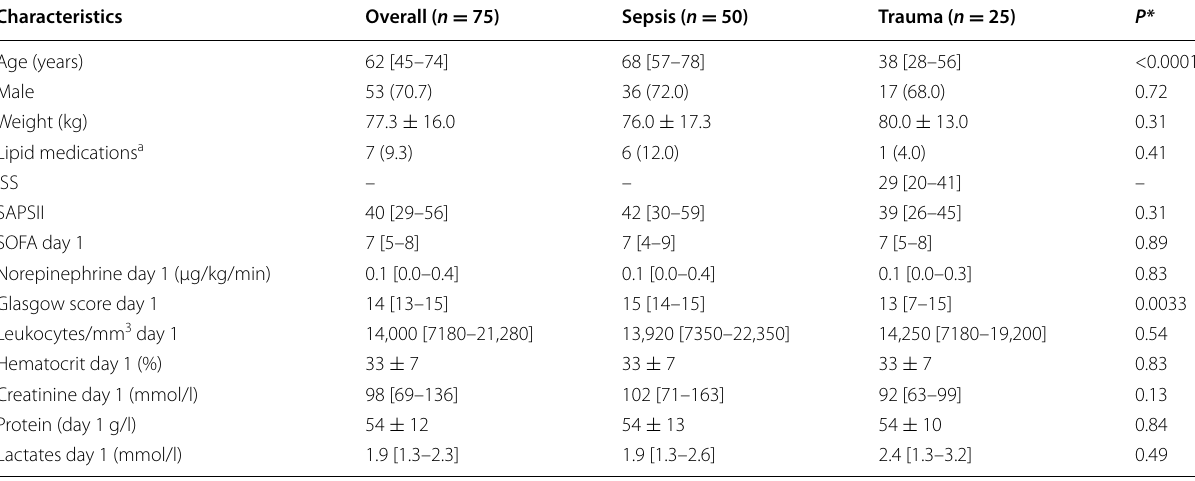
Values are frequencies (percentages), mean * P value for comparison between sepsis and trauma patients